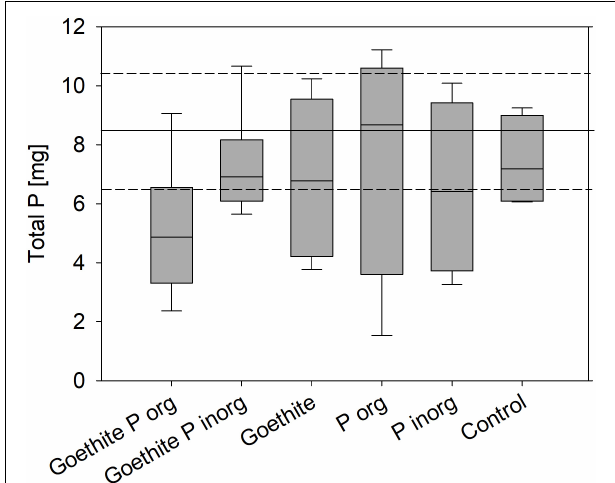
FIGURE 4 | Boxplots represent the sum of total P in trees at the end of the experiment and P lost with leaves during the first and second vegetation period; error bars represent standard errors; no statistical differences between treatments were detected. Black line marks total P in saplings at the start of the experiment; dashed lines represent standard error.